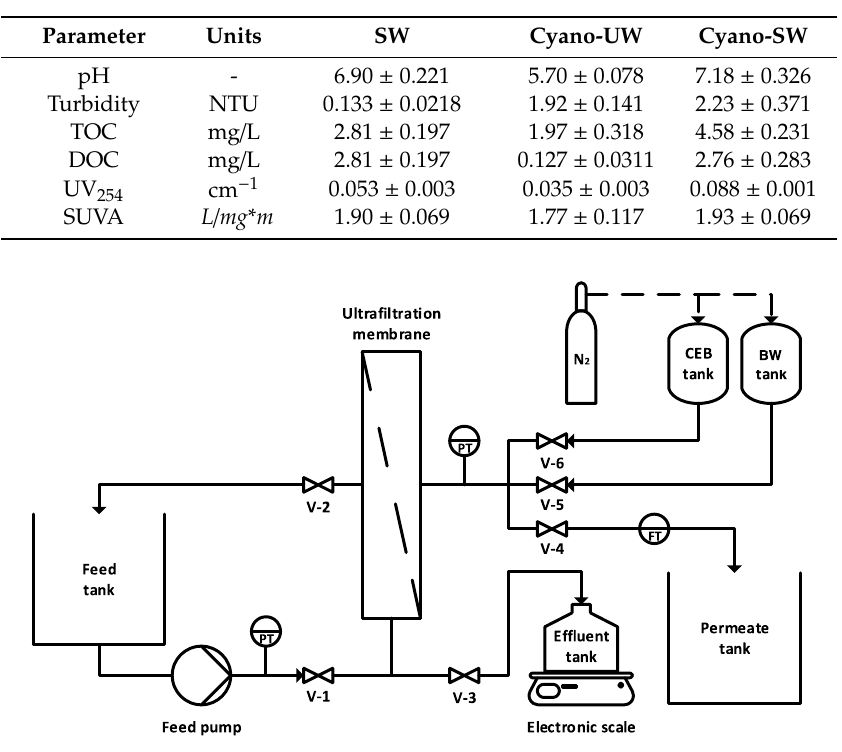
Figure 1. Schematic diagram of bench-scale ultrafiltration membrane system (PT: pressure transducer, FT: flow meter). Valves 1 and 4 are open during dead-end filtration; valves 3 and 5 are open during hydraulic backwashes; valves 3 and 6 are open during chemically enhanced backwashes; and